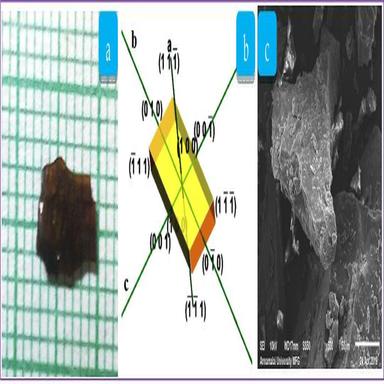
) Photo image (b) Crystal morphology (c) SEM image